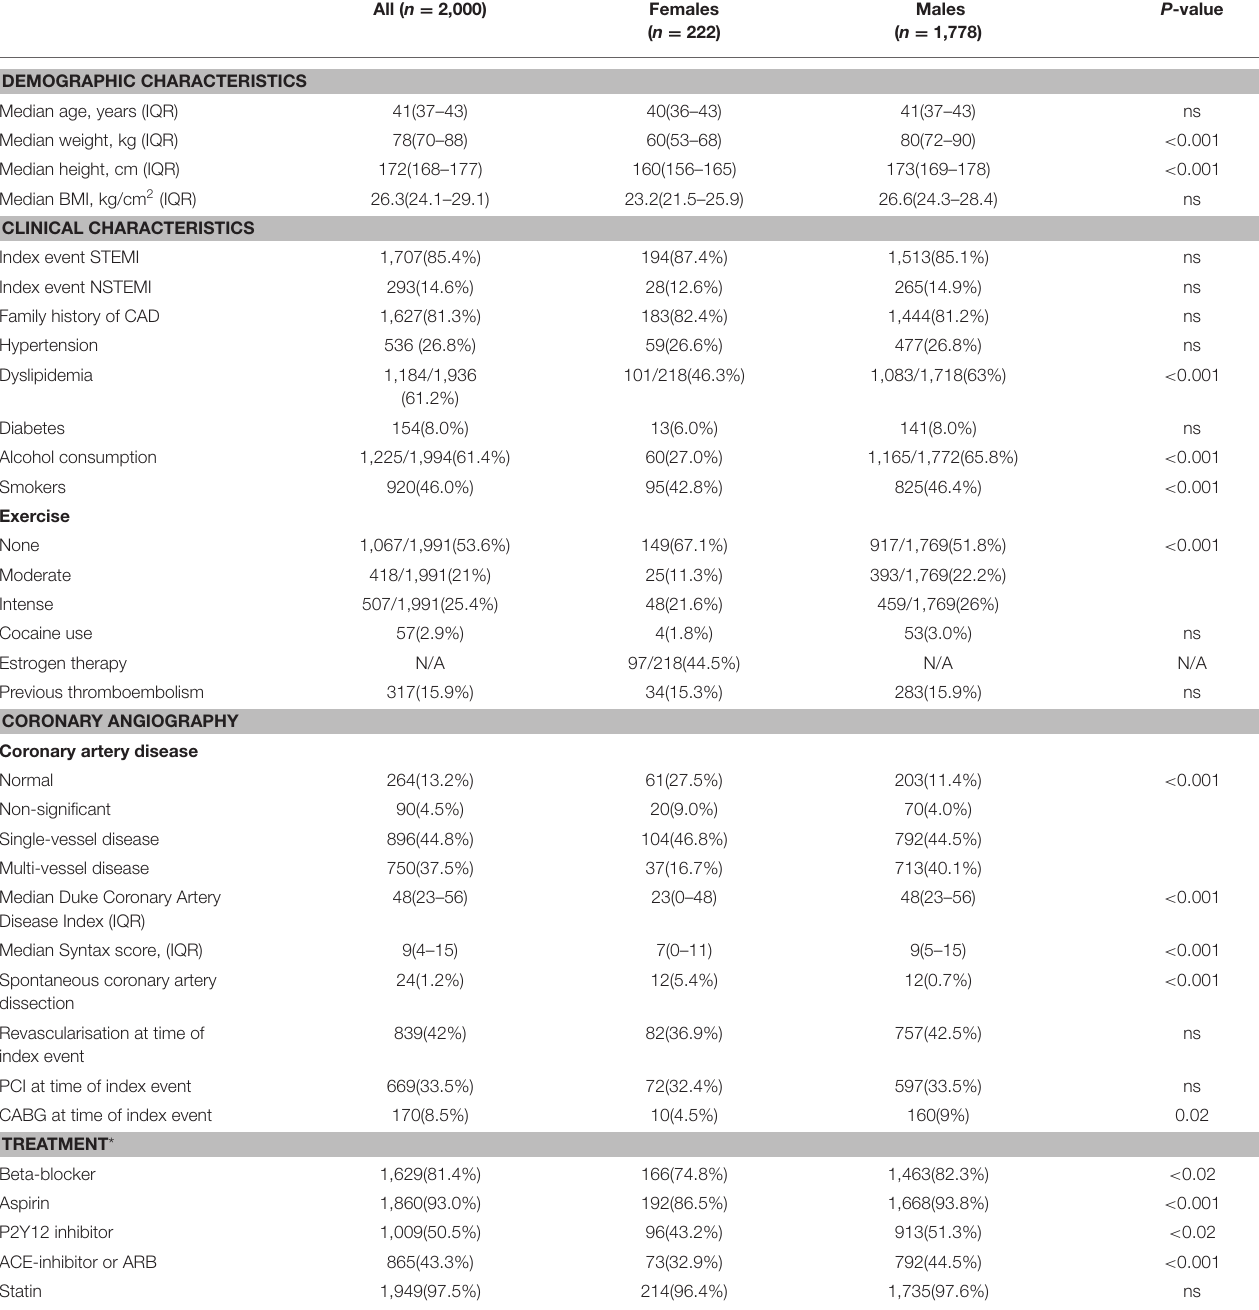
TABLE 1 | Baseline demographic, clinical, angiographic and treatment characteristics of the study population by sex. All ( n =